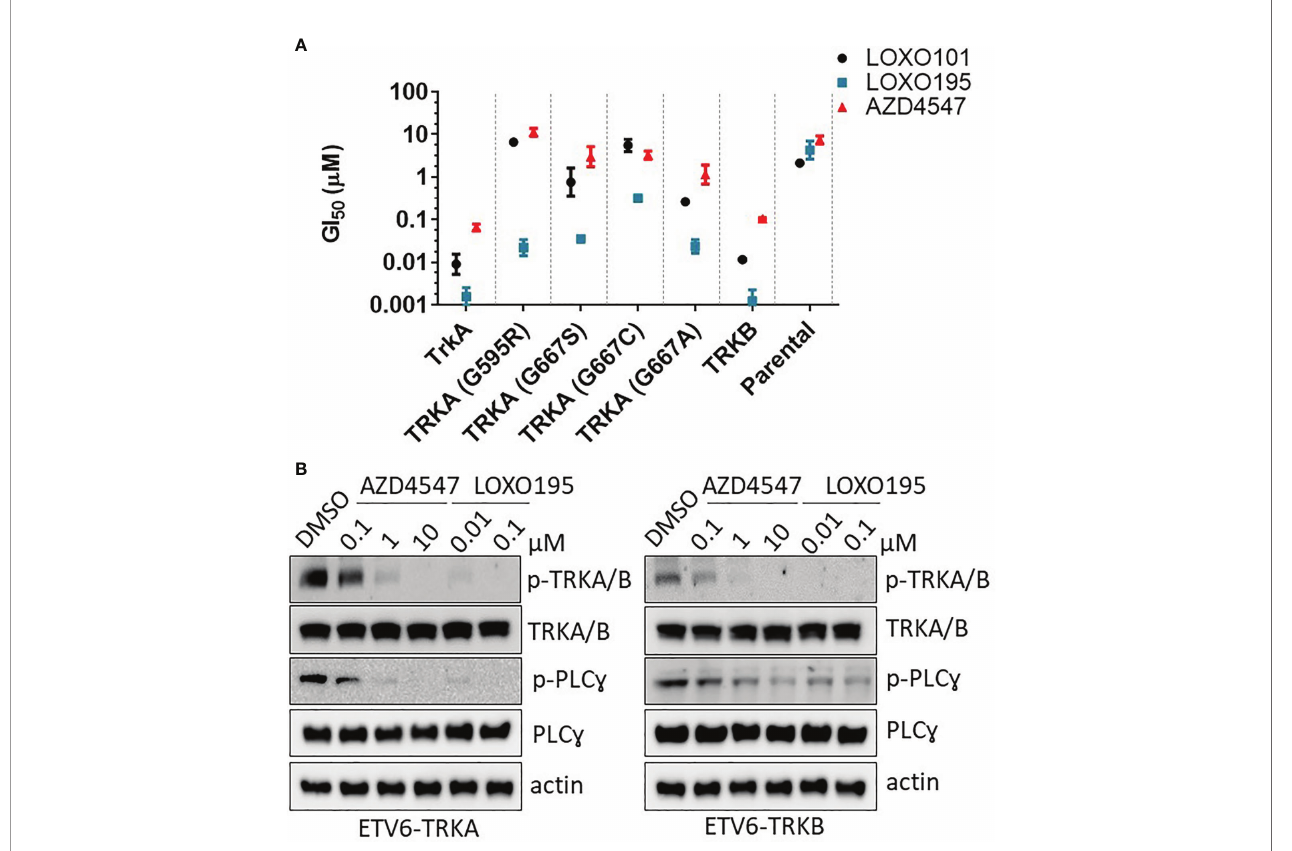
FIGURE 2 | Effects of AZD4547 on TRKA kinase mutants and TRKB. (A) Summary of GI 50 s of AZD4547 against Ba/F3: TRKA mutants or TRKB. Cell viability after 72 h exposure to the indicated inhibitors, determined by using a cell titer glo assay in duplicate mode. Data was plotted as mean GI 50 ± SD of two independent experiments. (B) AZD4547 inhibits phosphorylation of TRKA/B and PLC-gamma in Ba/F3 harboring TRKA and TRKB, respectively. The phosphorylation level of TRKA/B and PLC-gamma were monitored after 2 h treatment with AZD44547 or LOXO195. Data are representative of three independent